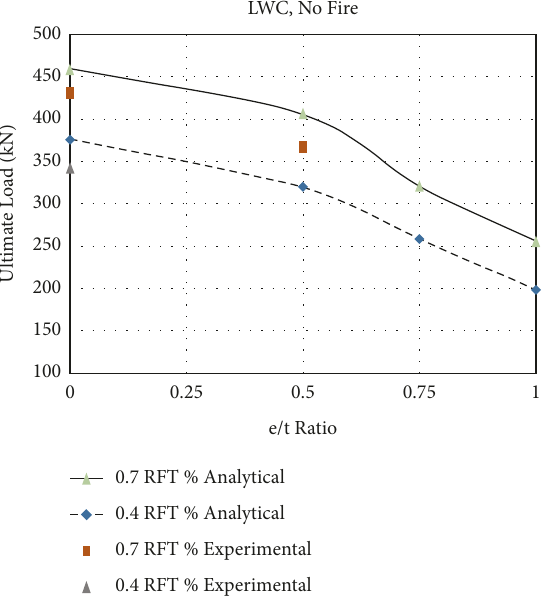
Figure 7: Effect of e/ t ratio on load for LWC the ultimate.